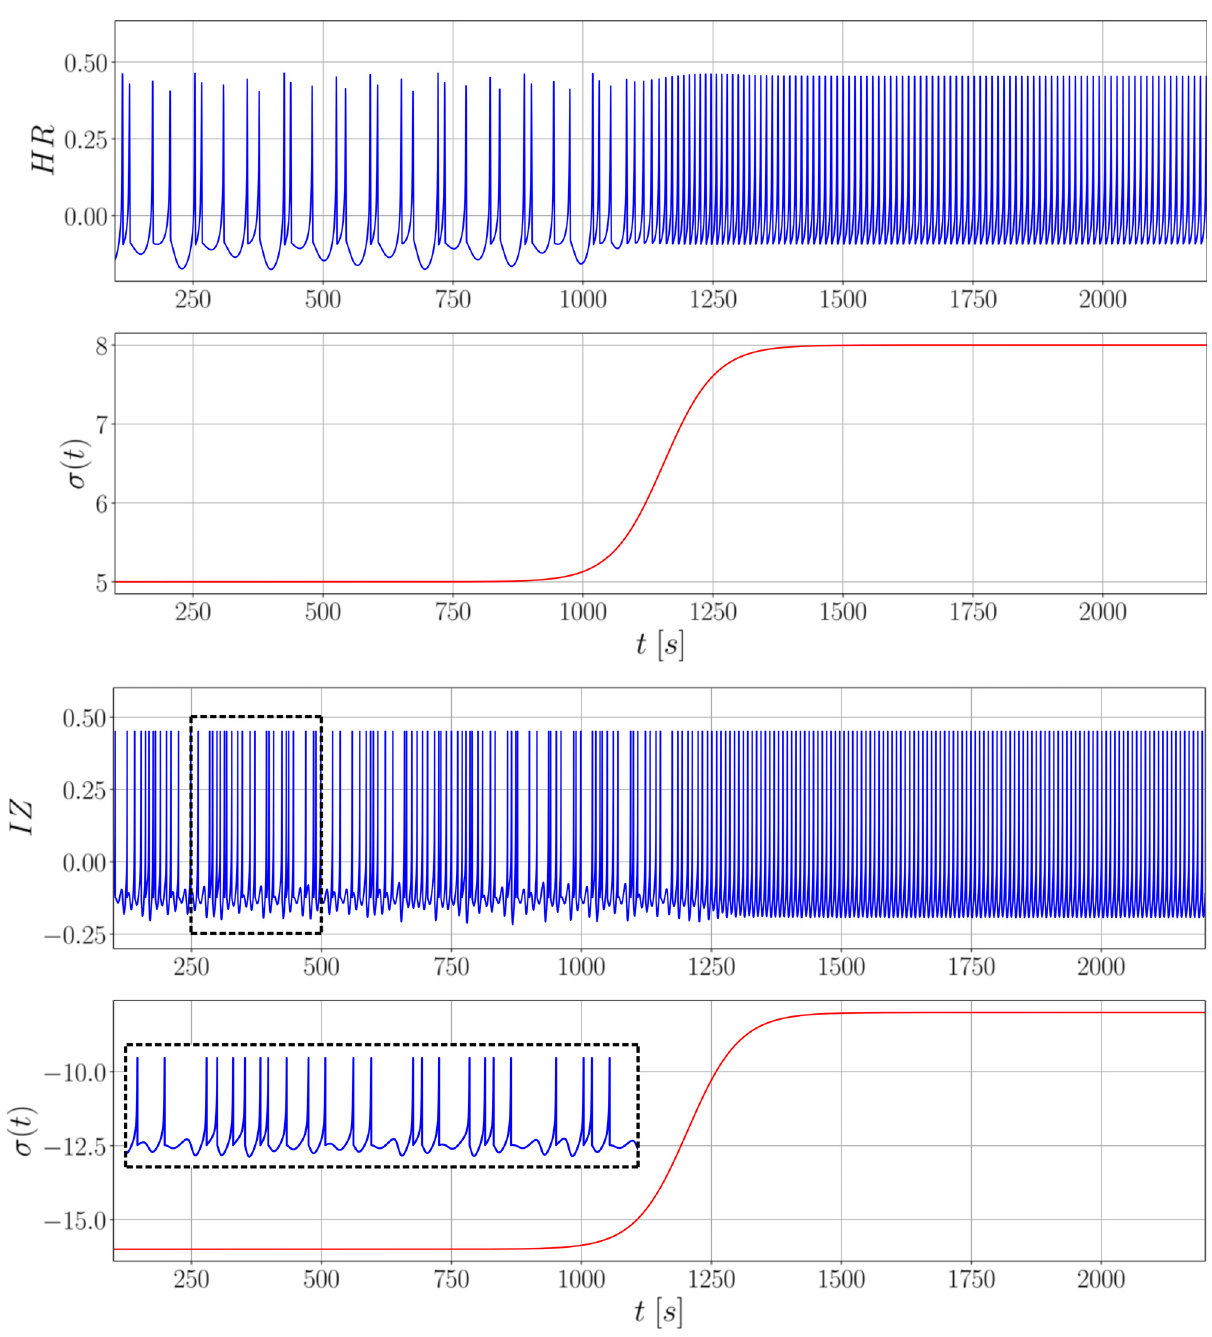
Fig 8. Transition between chaotic to regular behavior for the neuron dynamic models. The transitions for the Hindmarsh-Rose model (above) and Izhikevich model (below) are based on a sigmoid wave in function of the control parameters I and d , respectively. The time windows of both responses are similar, although Izhikevich’s model evolves in a relatively faster time